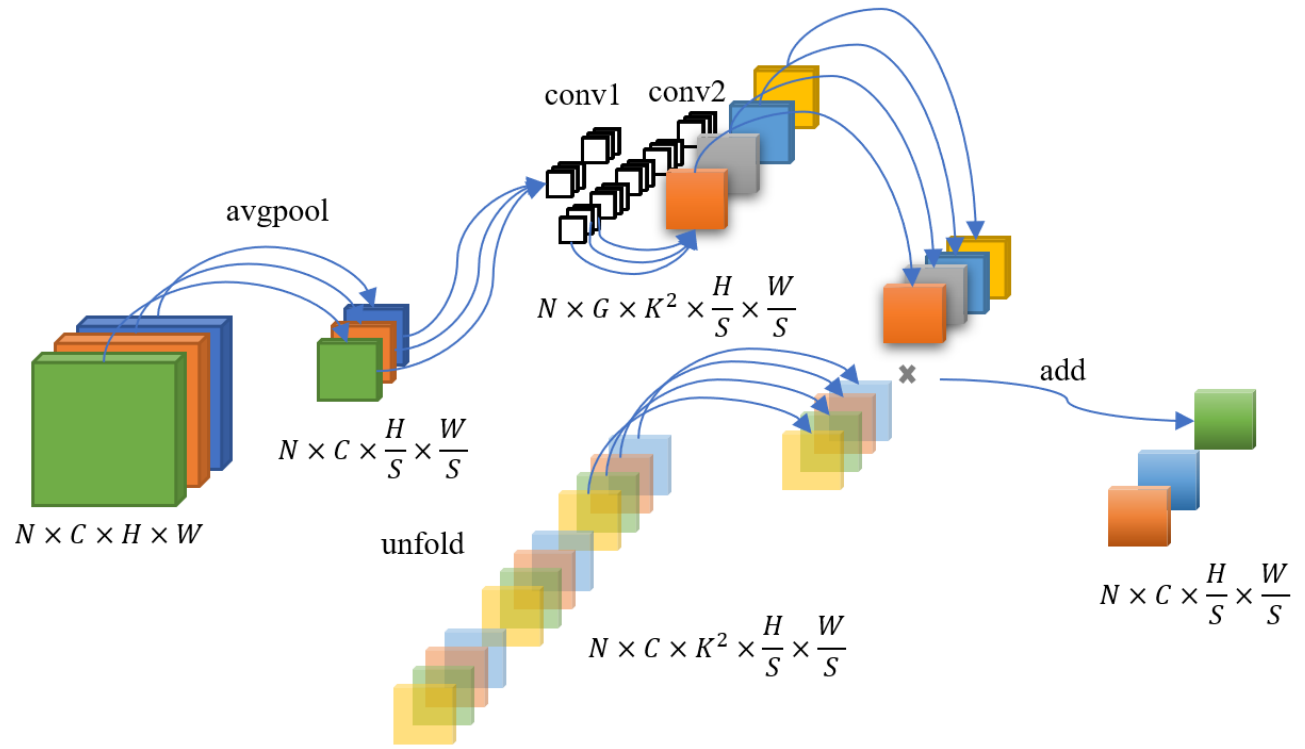
Figure 2. Method of extracting feature maps in the involution operator.